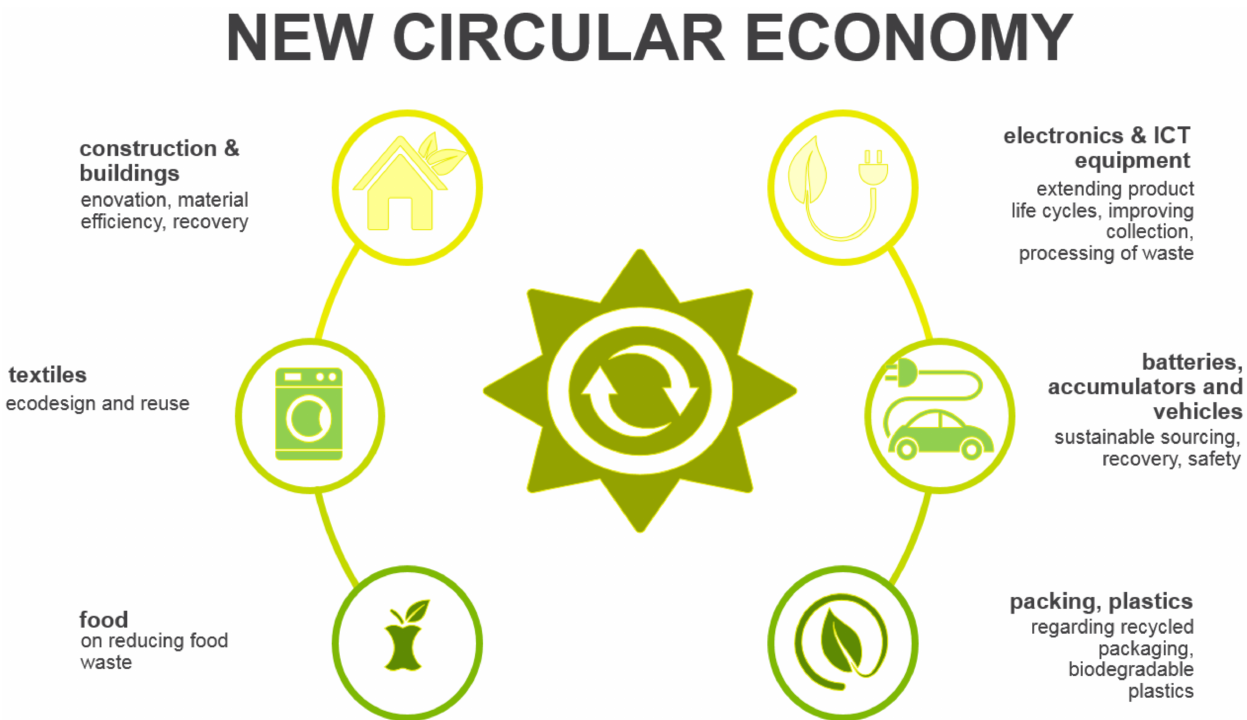
Figure 3. Changes in the selected sectors that consume the most resources according to the New Circular Economy in the